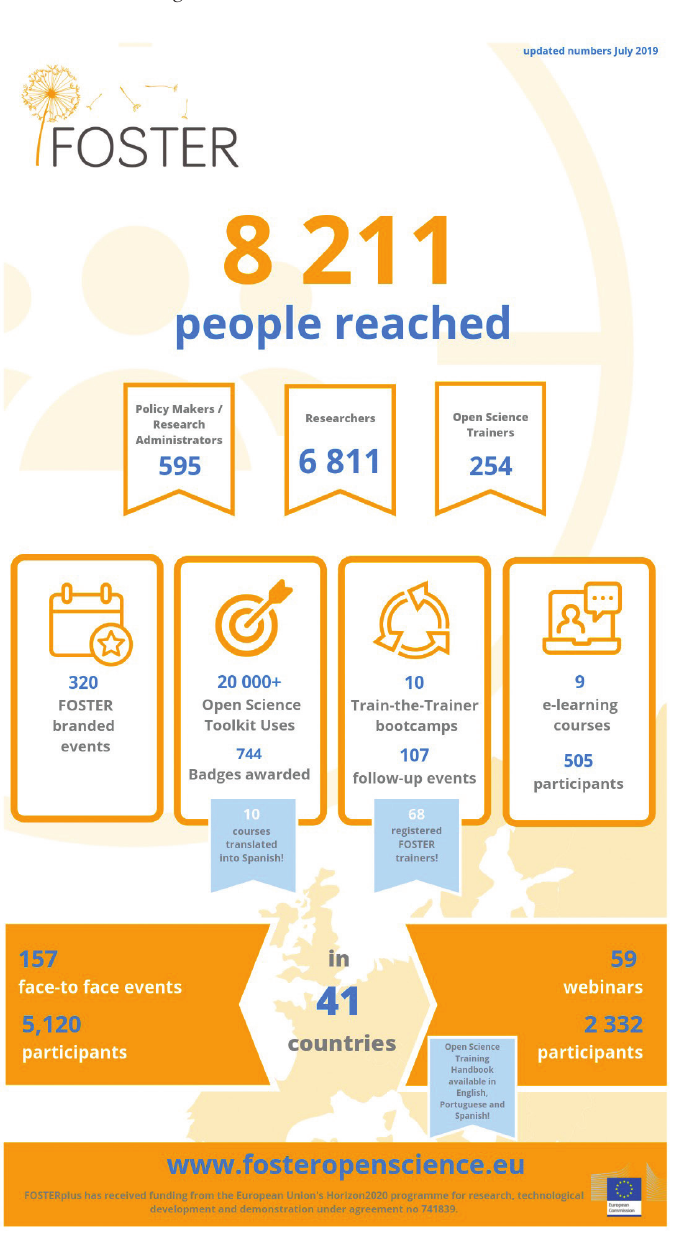
Fig. 9: FOSTER Plus training